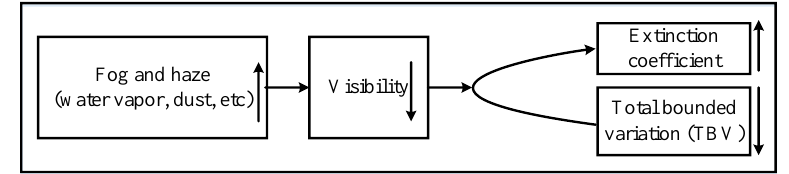
Figure 2. Relationship of atmospheric visibility, extinction coefficient and total bounded variation (TBV).